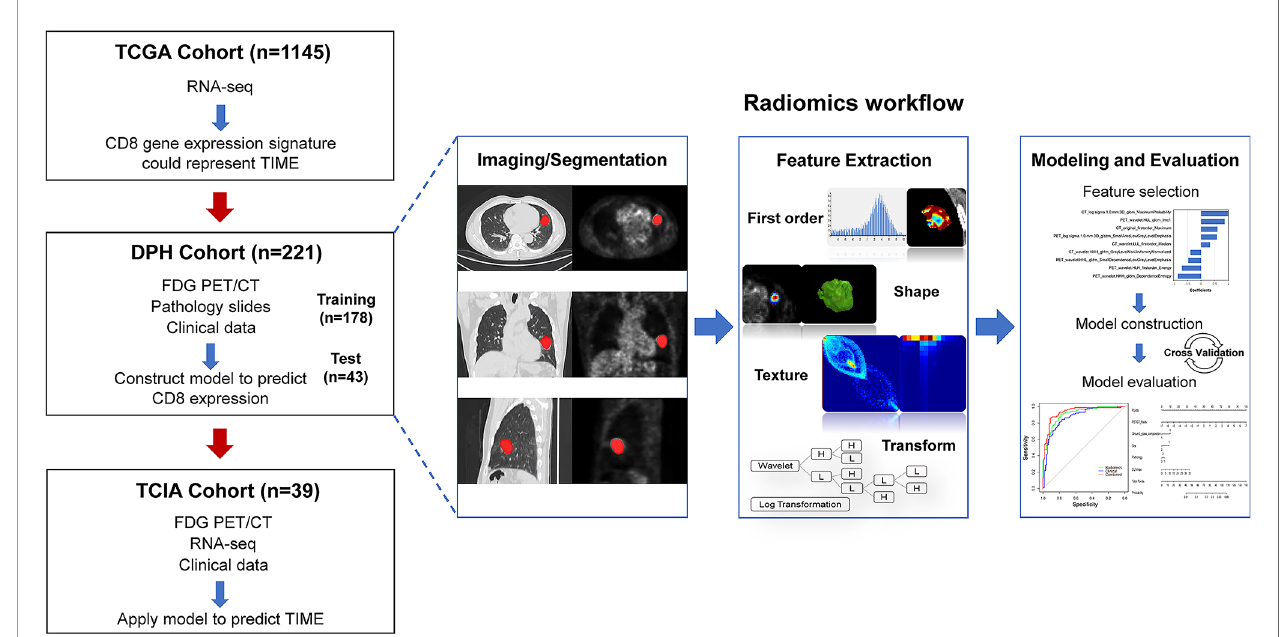
FIGURE 1 | The work fl ow of overall study. Firstly, we evaluated whether CD8 expression signature could represent the TIME pro fi les by using the RNA-seq data in TCGA cohort (n = 1145). Then, machine learning model was trained and validated using DPH cohort (n = 221) with 18 F-FDG PET/CT radiomics-clinical features to predict CD8 expression status. The model was then applied to predict TIME phenotypes in TCIA cohort (n = 39). The right row is the radiomics work fl